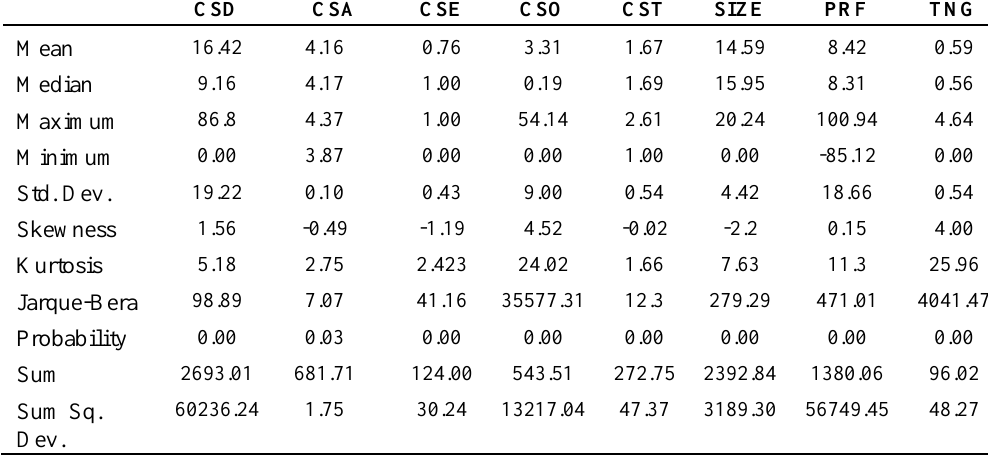
Table 2: Descriptive Statistics